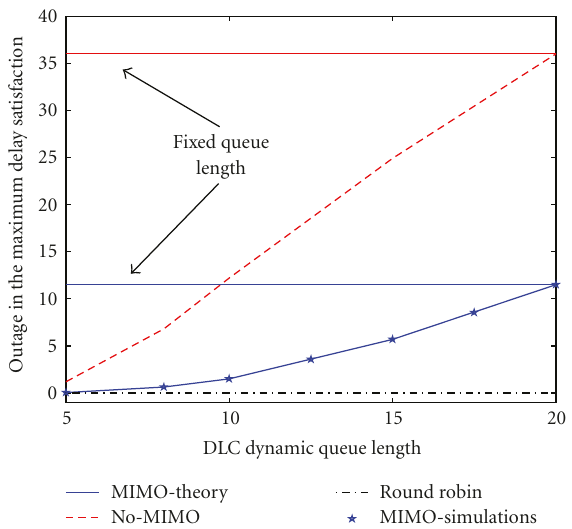
Figure 2: Outage probability (%) in the maximum delay satisfac- tion for Class 1 users, with a maximum allowed delay threshold = 20ms.